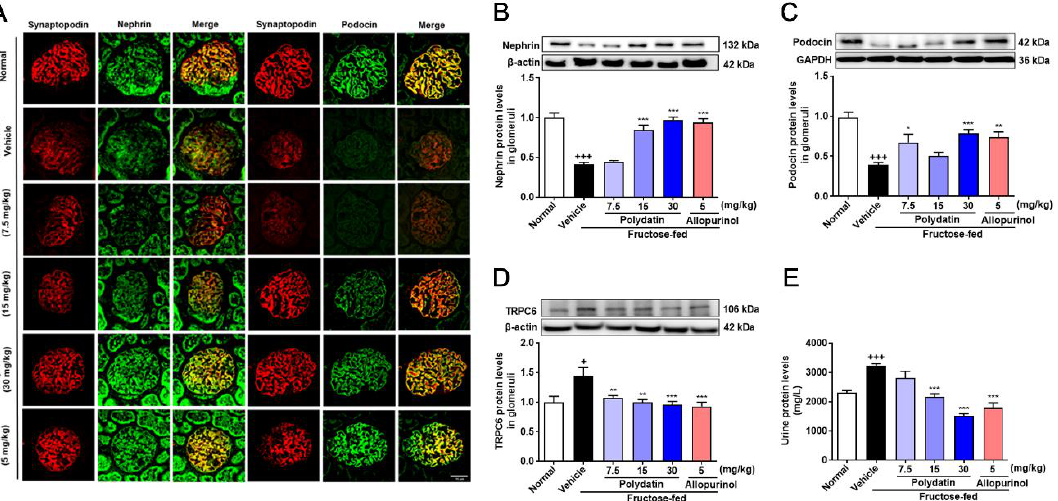
Figure 6. Polydatin attenuates glomerular podocyte structure damage in high fructose-fed rats. Rats were fed 10% fructose water (wt/vol) for 13 weeks and treated with polydatin (7.5, 15, and 30 mg/kg) and allopurinol (5 mg/kg) for 7 weeks. ( A ) Representative immunofluorescence images of kidney glomeruli stained with nephrin (green) and podocin (green) and synaptopodin (red) were examined by a confocal laser scanning microscope (scale bar, 25 µ m) ( n = 3). ( B – D ) Relative protein levels of nephrin ( n = 5–8) ( B ), podocin ( n = 6–7) ( C ), and TRPC6 ( n = 4–5) ( D ) were detected in rat glomeruli by Western blot and quantified by Image J. ( E ) Rat urine protein levels were detected by biochemical kit ( n = 6–7). Data are expressed as the mean ± S.E.M. + p < 0.05, +++ p < 0.001 compared with normal